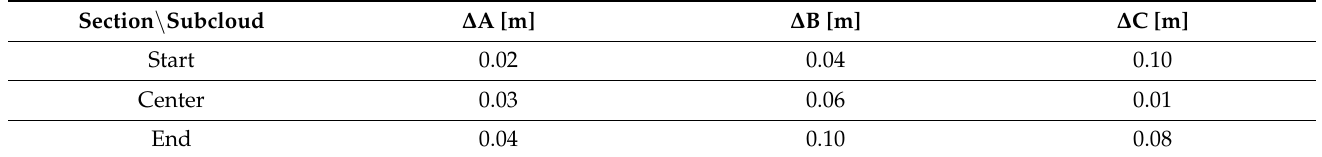
Table 6. SfM/TLS comparison results.